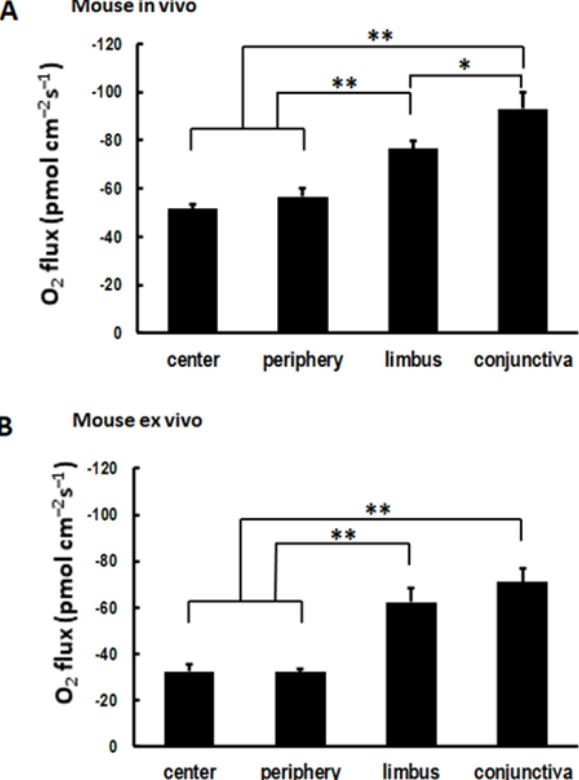
Figure 3. Cornea of enucleated eyes maintained the centripetal gradient. ( A ) O 2 uptake across the cornea measured in vivo in mice showed centripetal uptake pattern. ( B ) O 2 uptake across the cornea measured ex vivo in mice showed centripetal uptake pattern (*: p < 0.05; **: p < 0.01). Data are expressed as mean ± S.E.M. from eight eyes in four mice.